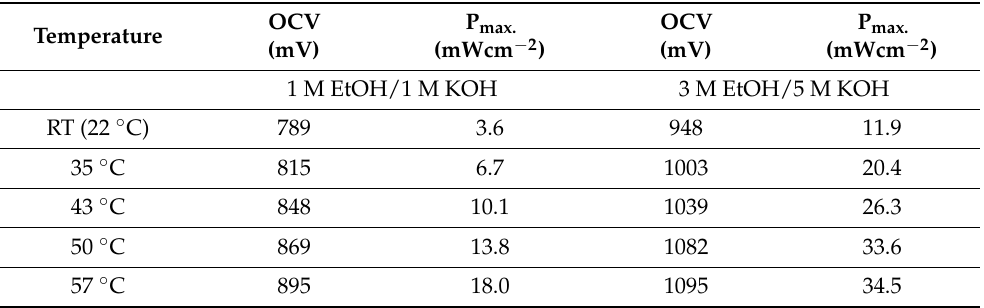
Figure 10. Typical Direct Ethanol Alkaline Fuel Cell (DEAFC) discharged cell voltage and power density of ( a ) CS membranes at room temperature with 1 M EtOH/1 M KOH, ( b – d ) CS membranes at 57 °C and 1 M EtOH/1 M KOH, and ( e – f ) CS membranes at 57 °C and 3 M EtOH/5 M KOH. Table 1. Open circuit voltage (OCV) and P max . of CS/N-rGONRs (0.07%) as a function of temperature and concentration.